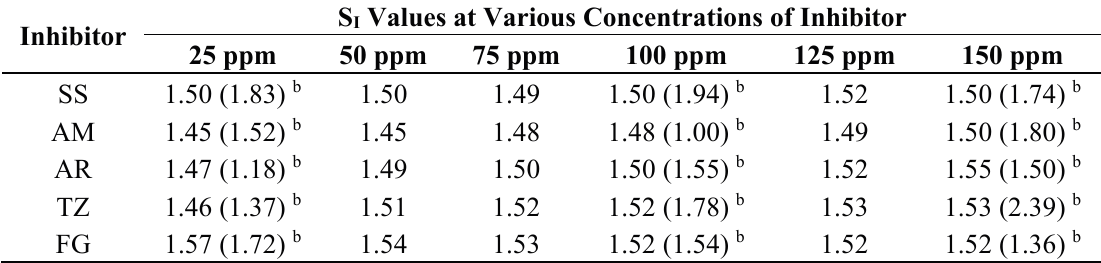
Table 4. Synergistic parameters (S I ).